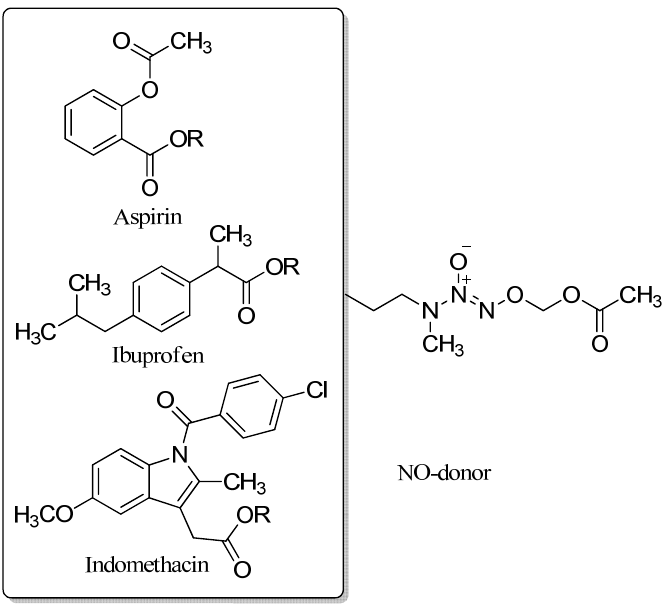
Figure 22. Mutual NONO/NSAID prodrug